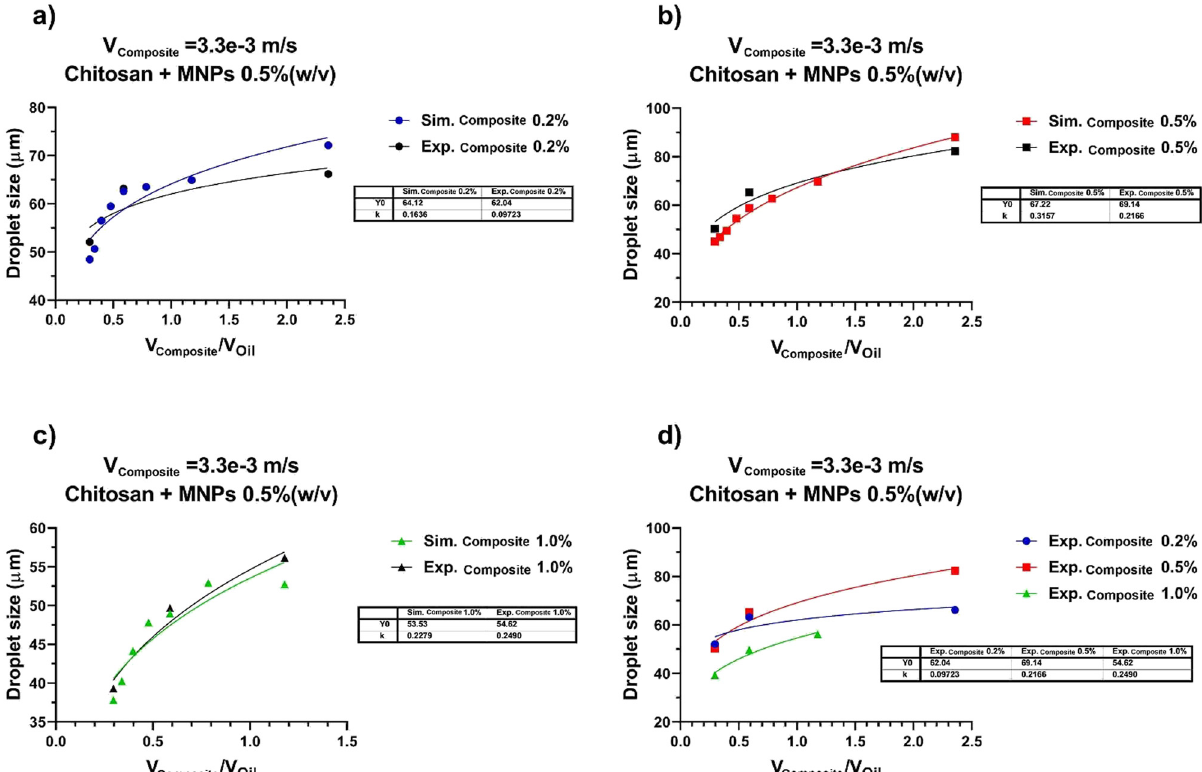
Figure 6: Comparisons of the microgel droplet size of the simulation and experimental results. ( a ) 0.2% CS; ( b ) 0.5% CS; ( c ) 1.0% CS; ( d ) the e ff ect of the CS concentration on the microgel droplet